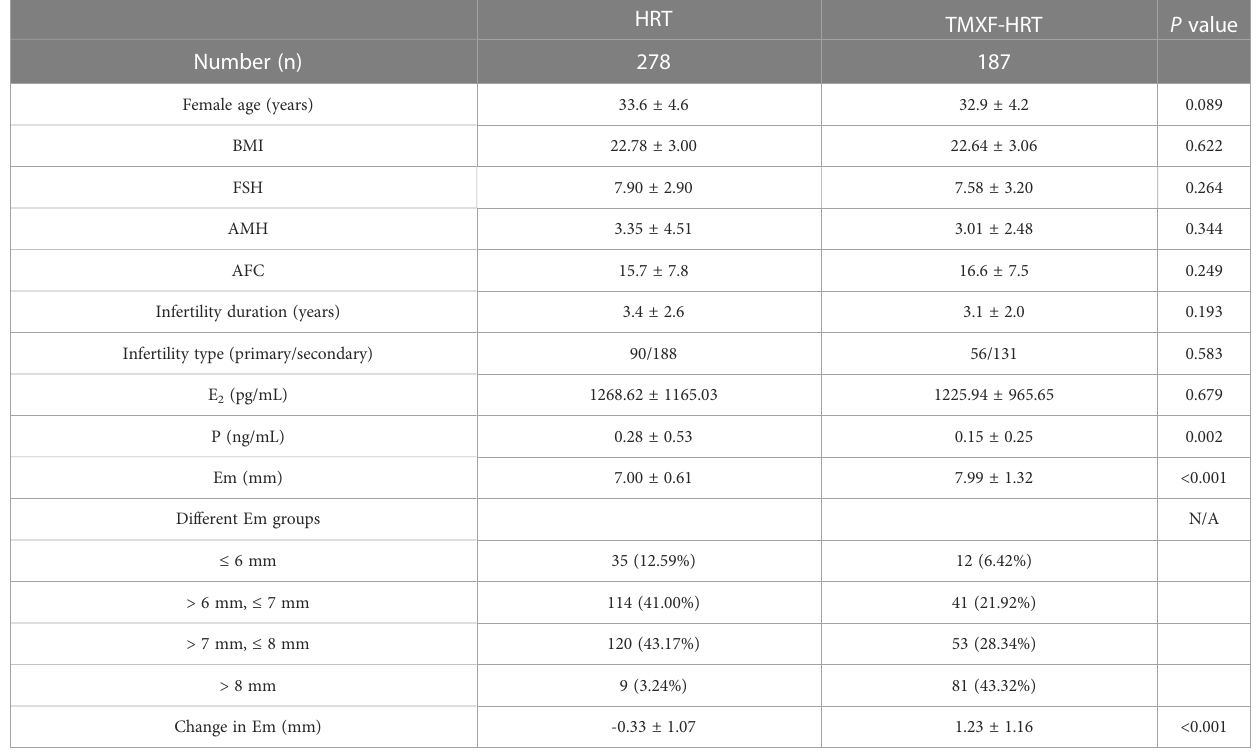
TABLE 1 General data in HRT cycles versus tamoxifen in combination with HRT